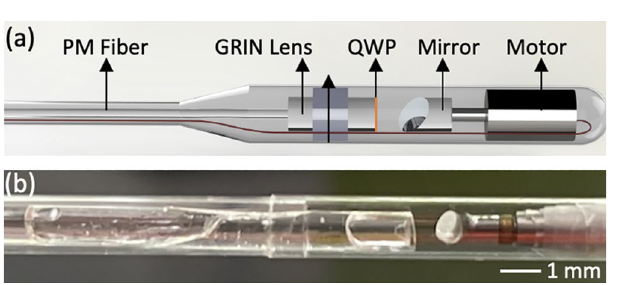
Figure 5. The schematic of IV-PSOCT system: ( a ) system setup, ( b ) scan head, and ( c ) intravascular imaging probe. PM polarization maintaining, SM single mode, QWP quarter-wave plate. The figure is generated by using PowerPoint (Version 16.58, https:// www. micro soft. com/ en- us/ micro soft- 365/ power point).